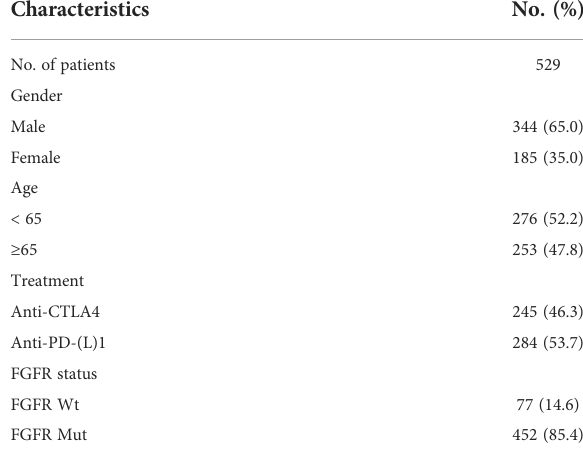
TABLE 1 Patient characteristics in the ICIs-treated